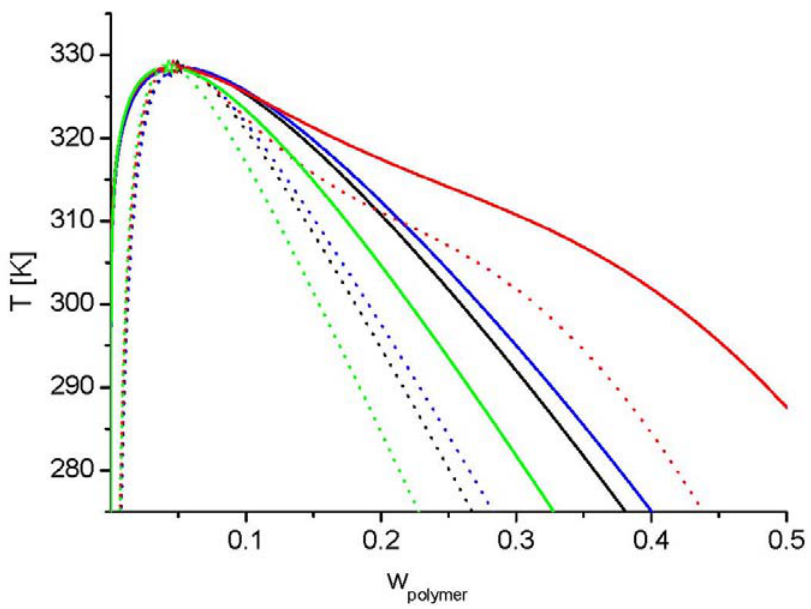
Figure 7. Calculations of LLE for the system linear polymer in a solvent occupying only one lattice site (solid line: binodal line, dotted line: spinodal line, stars: critical points), where the black colour depicts the results using the LCT with z = 12; = 35 K , the blue colour those with z = 10; ε / k = 43.86 K , the red colour those with ε / k B B = 93.62 K , and the green colour presents the results obtained by FH theory z = 6; ε / k B